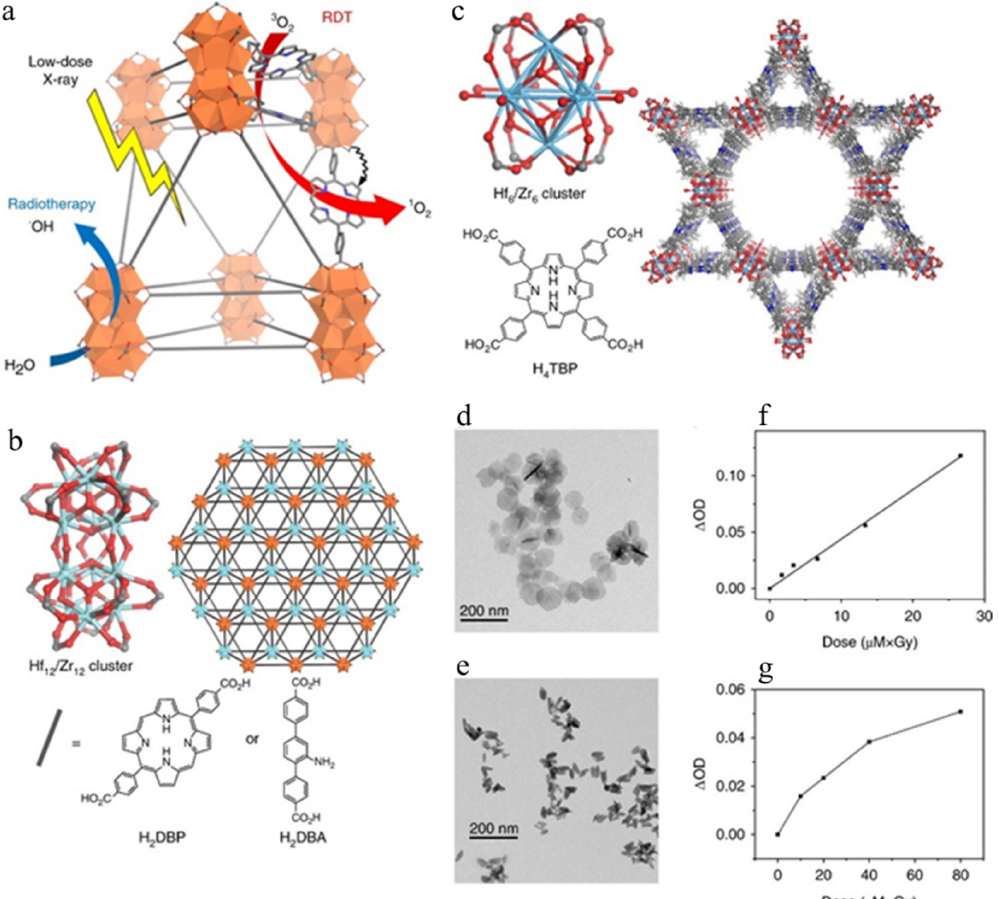
Figure 6. ( a ) Schematic illustration of the mechanisms of X-ray-induced RT–RDT by MOF nanocrystals. ( b ) Structure models of Hf 12 /Zr 12 secondary building units (SBUs), and 5,15-di( p -benzoato)porphyrin-Hf (DBP-Hf), 5,15-di( p -benzoato)porphyrin-Zr (DBP-Zr) and 2,5-di( p -benzoato)aniline- Hf (DBA-Hf) MOFs nanocrystals. ( c ) Structure models of Hf 6 /Zr 6 SBUs, and TBP-Hf and TBP-Zr nMOFs. ( d , e ) Transmission electron microscopy images of DBP-Hf ( d ) and TBP-Hf ( e ). The nMOF syntheses were repeated more than 20 times in each case and the particle morphologies and sizes were similar. ( f , g ) 1 O 2 generation of DBP-Hf ( f ) and TBP-Hf ( g ) upon X-ray irradiation (225 kVp, 13 mA), as determined by 4-nitroso-N,N-dimethylaniline assay. For DBP-Hf, the change in optical density ( ∆ OD) at 439 nm is linearly fitted against the product of MOFs concentration ( µ M) and X-ray dose (Gy). For DBP-Hf or TBP-Hf samples irradiated with 10 Gy at Hf concentrations of 10 µ M, two independent experiments were performed, and similar results were obtained. Reprinted